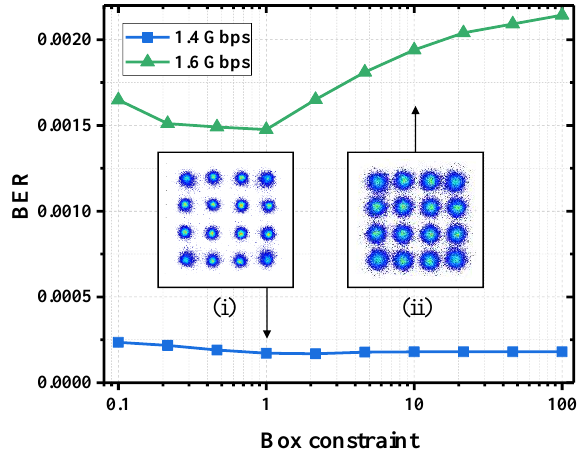
Figure 7. BER versus box constraint at 1.4 Gbps and 1.6 Gbps. (i) and (ii) are constellations at 1.4 Gbps and 1.6 Gbps respectively.